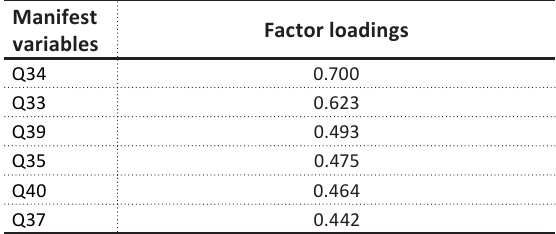
Table 9. Fake and insincere brand activism triggers backlash among the millennials